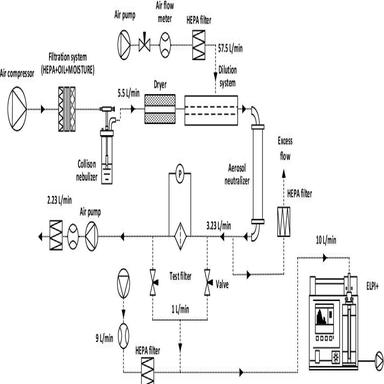
Experimental setup for filtration efficiency and pressure drop measurements.